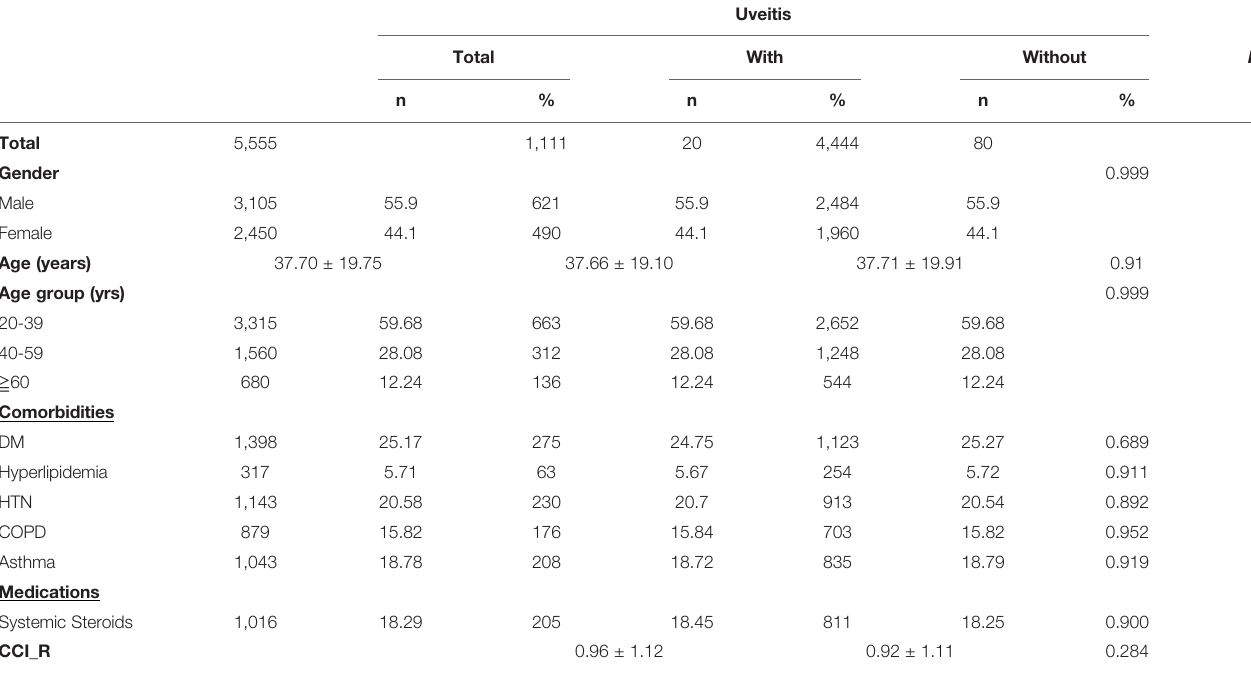
TABLE 1 | Characteristics of the study and comparison population at baseline. Uveitis Total With Without